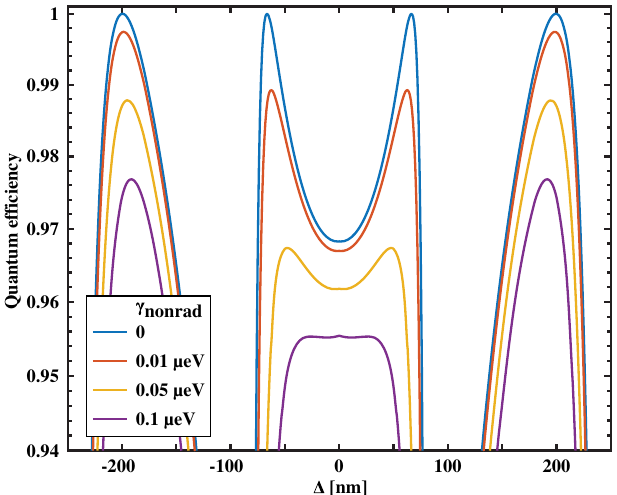
FIG. 6. Quantum efficiency of a QD in a PC cavity as a function of Δ , simulated for a set of nonradiative decay rates γ